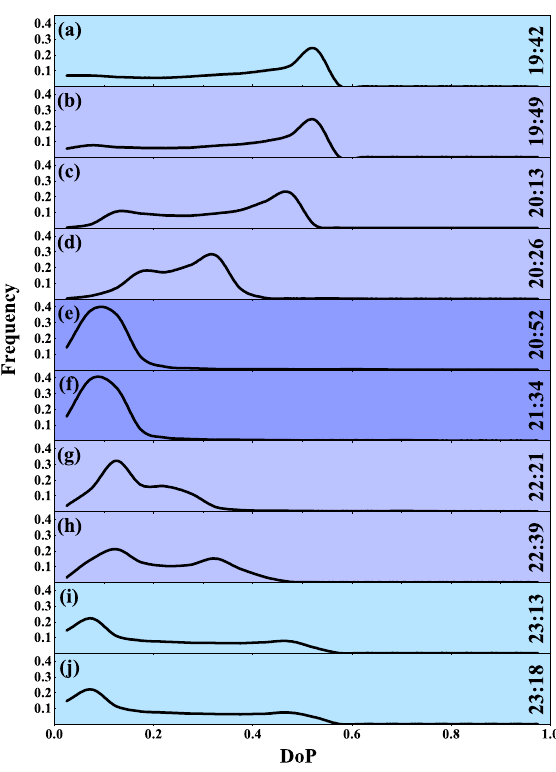
Figure 2. Frequency changes of the Degree of Polarization (DoP) in different stages of the Super Blue Blood Moon (SBBM). The stages of lunar eclipse are represented by different colors. ( a – j ) Frequency of DoP in realistic sky corresponding to the recording time on 31 January in Table 2. The time shown above is Local Time